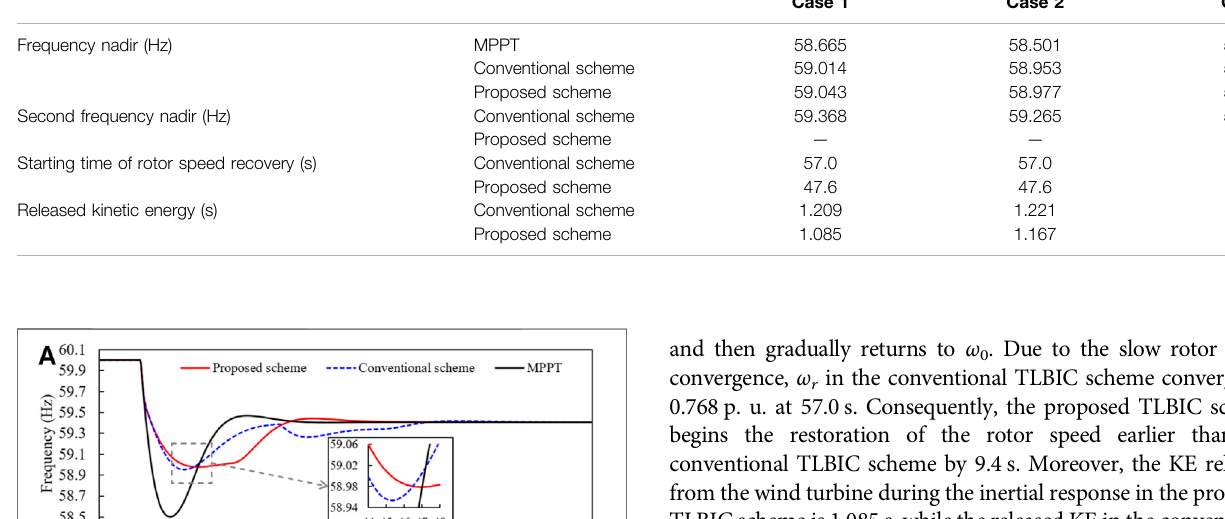
Frontiers in Energy Research |